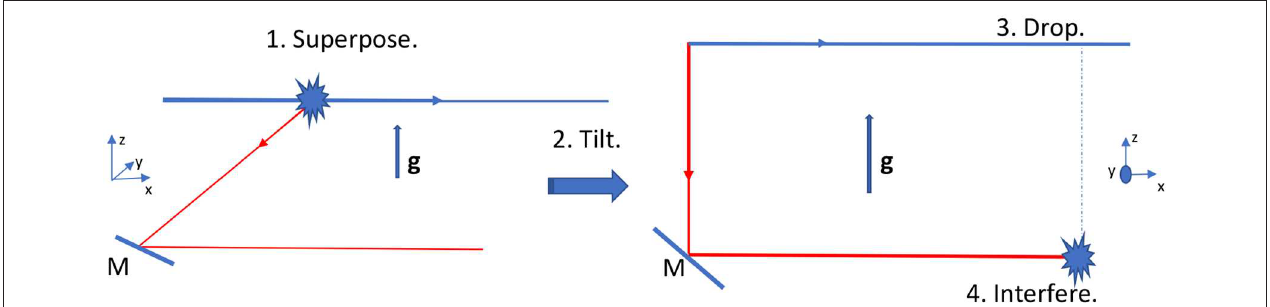
FIGURE 1 | Schematics of the interferometry to measure the t 3 phase. On the left, the particle is superposed across two paths (M is a mirror; g the gravitational field). On the right, after tilting the interferometer in the vertical direction, the interferometry is closed by dropping the particle if it is on the upper branch.